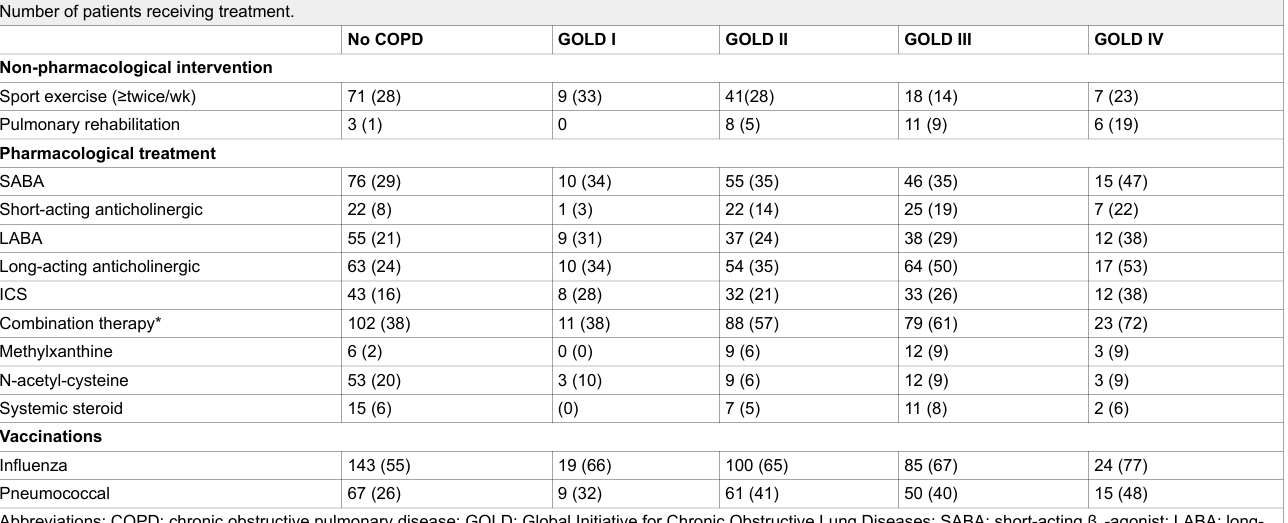
Table 4 Number of patients receiving treatment.